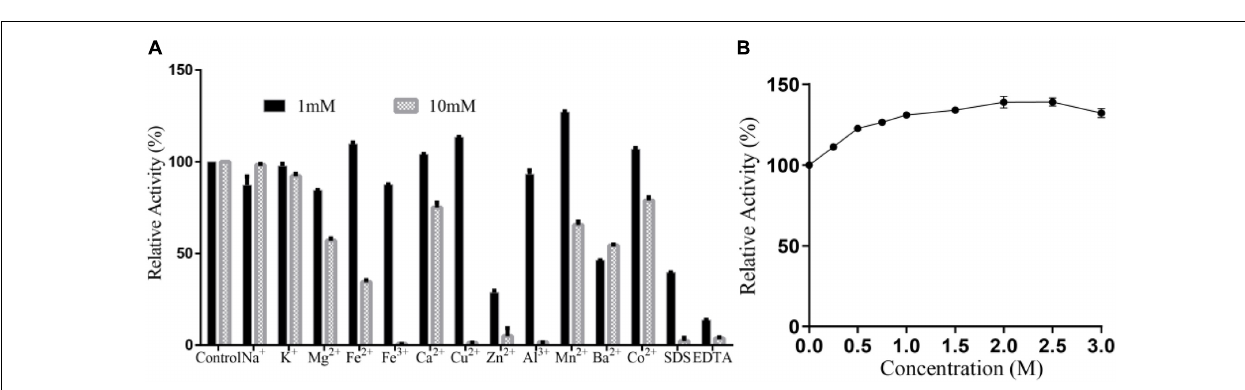
and disaccharides (351.00 m / z ), indicating that the current Alyw203 enzyme effectively degrades alginate polymers into monosaccharides and disaccharides in an endo-type